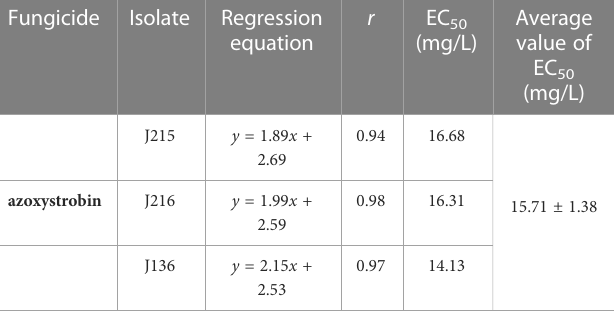
TABLE 1 In vitro activity of azoxystrobin against mycelial growth of Rhizoctonia solani isolates J215, J216 and J36 from tobacco. Fungicide